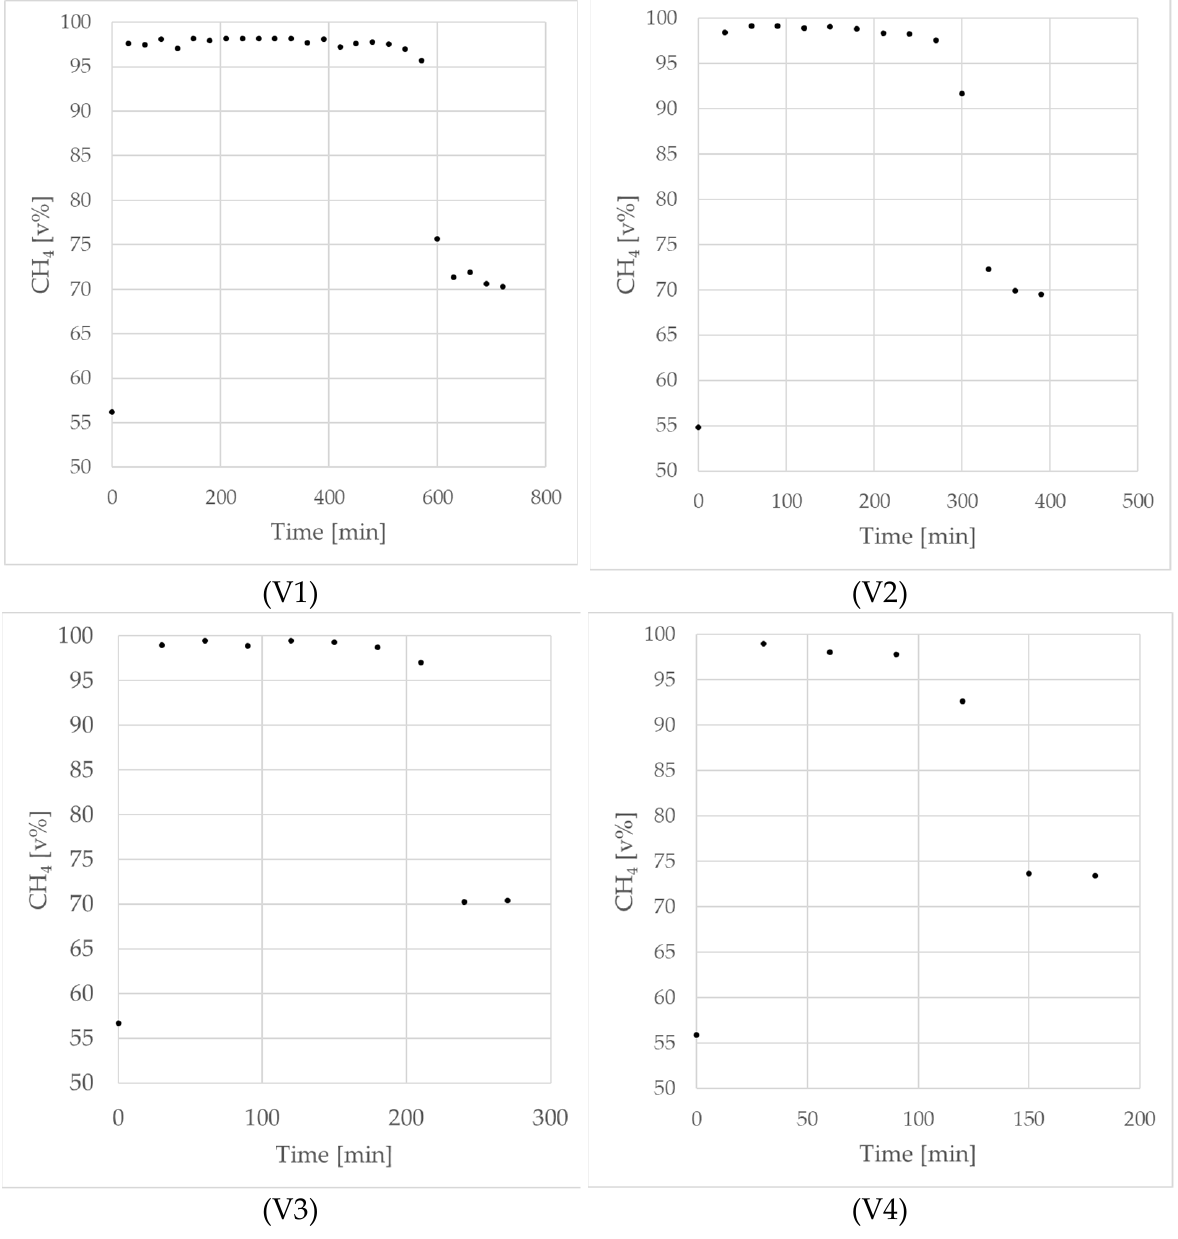
Figure 5. Effect of biogas flow rate on biogas upgrading: (V1) 5 mL/min; (V2) 10 mL/min; (V3) 15 mL/min; (V4) 20 mL/min. Table 4. Upgraded biogas characteristics in comparison with raw biogas (as average).